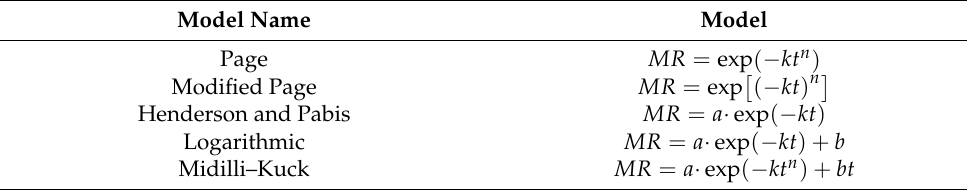
Table 1. Mathematical models applied to the drying curves in the